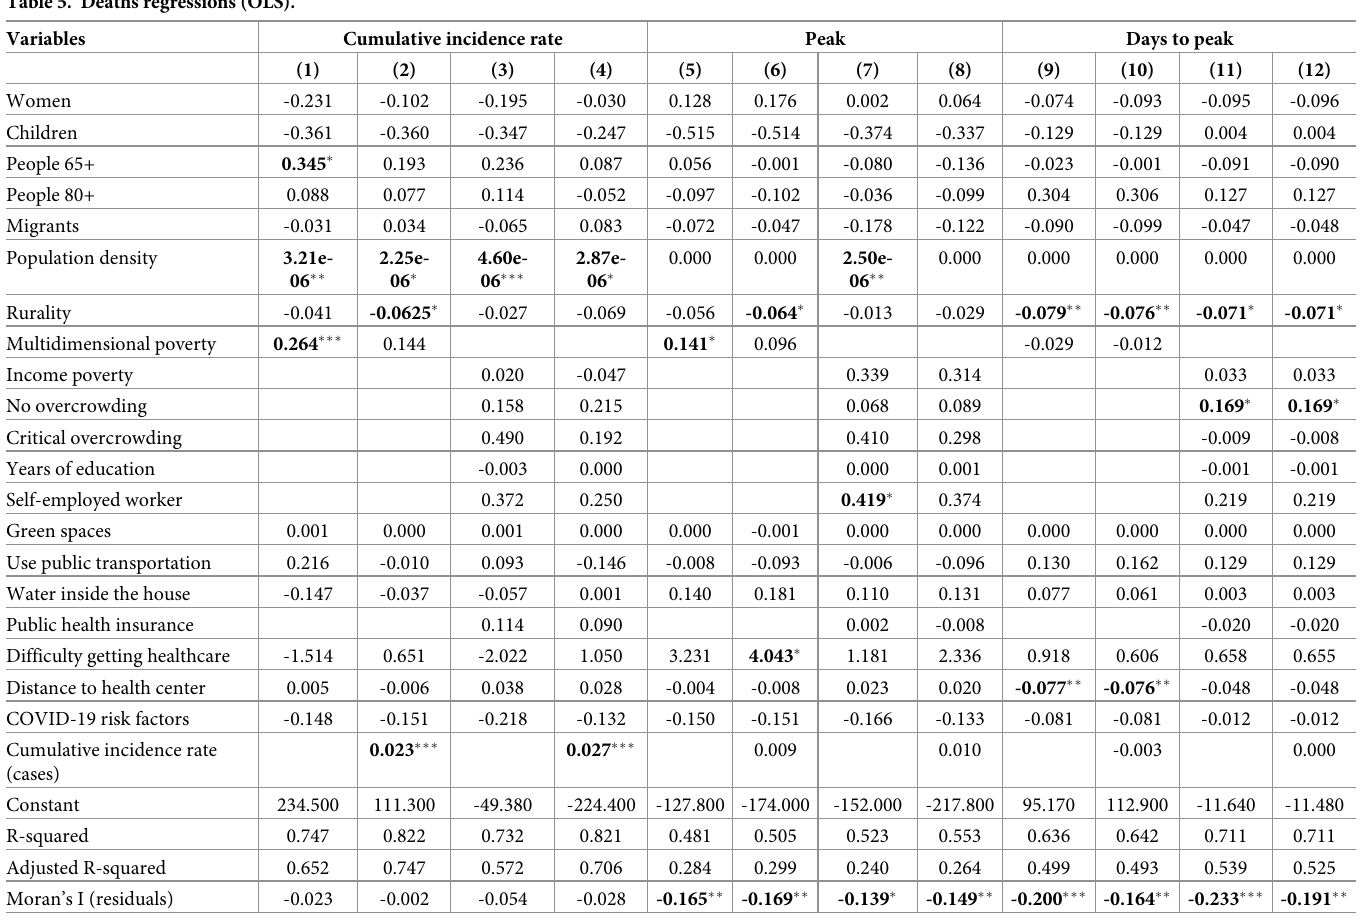
Table 5. Deaths regressions